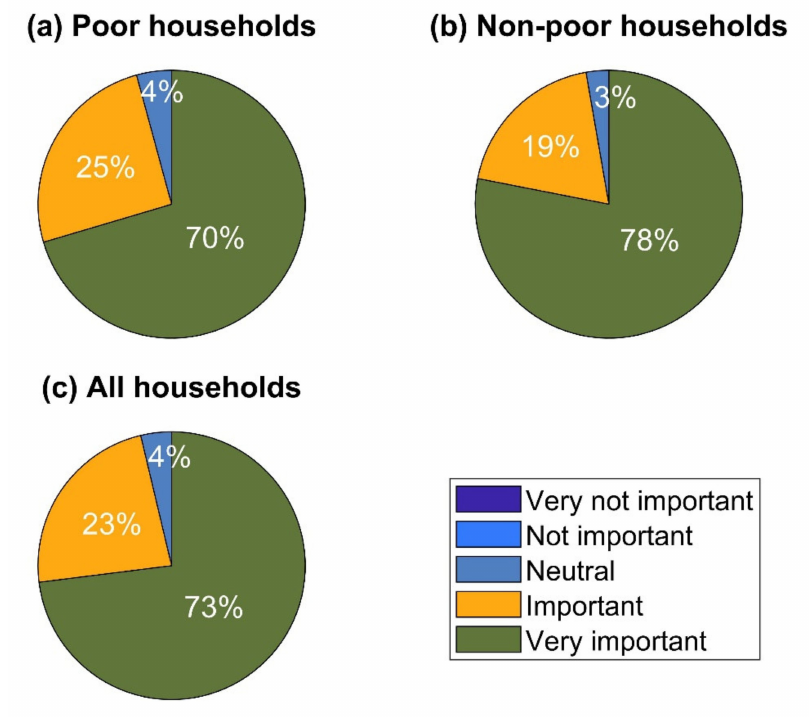
Figure 2. Forest importance perceived. Source